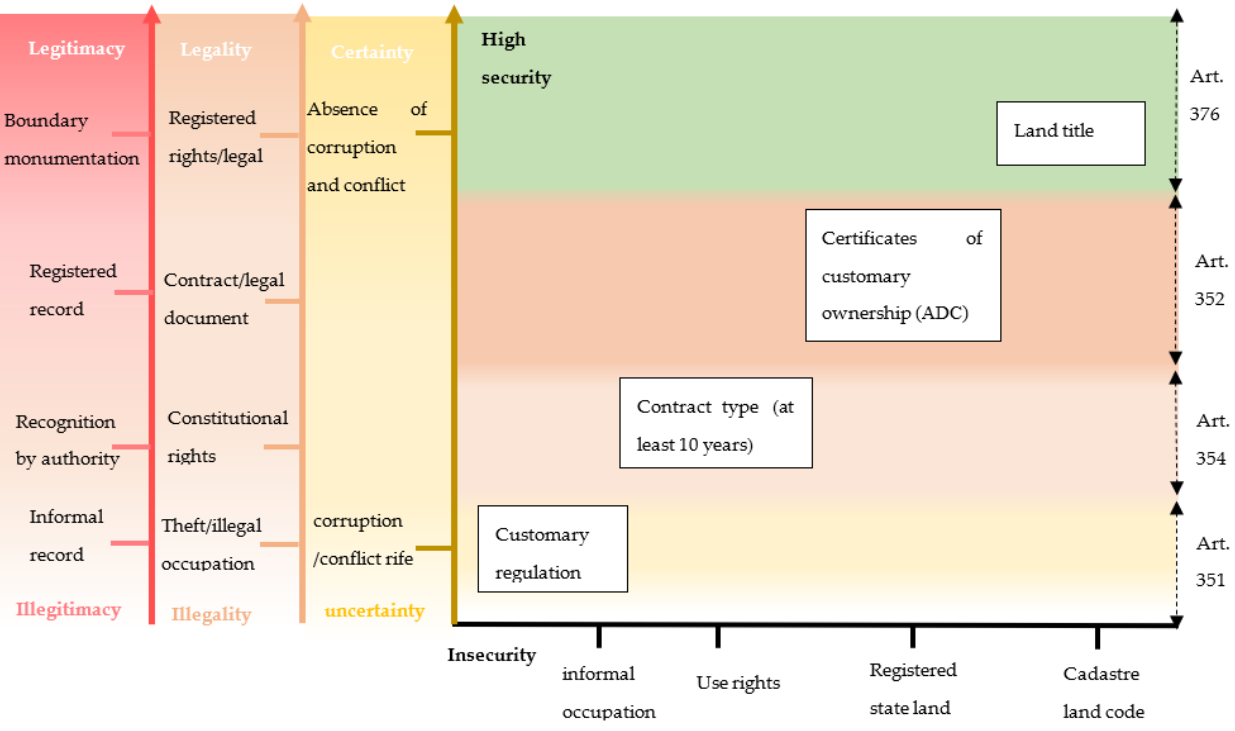
Figure 3. Land rights and land tenure security according to the domain and code of land law.